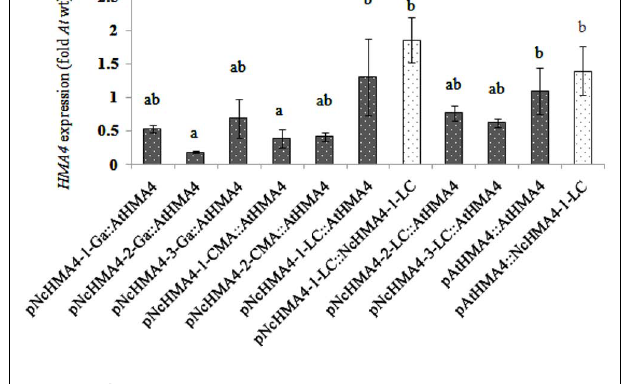
FIGURE 3 | AtHMA4 (solid bars) and NcHMA4-1-LC (open bars) expression under A. thaliana and N. caerulescens promoters in the root of transgenic A. thaliana hma2hma4 double mutants, relative to the average expression in the root of A. thaliana wild-type which is considered as 1 (means of 5 plants ± SE) . Significant differences ( P < 0.05) between means are indicated by different superscripted